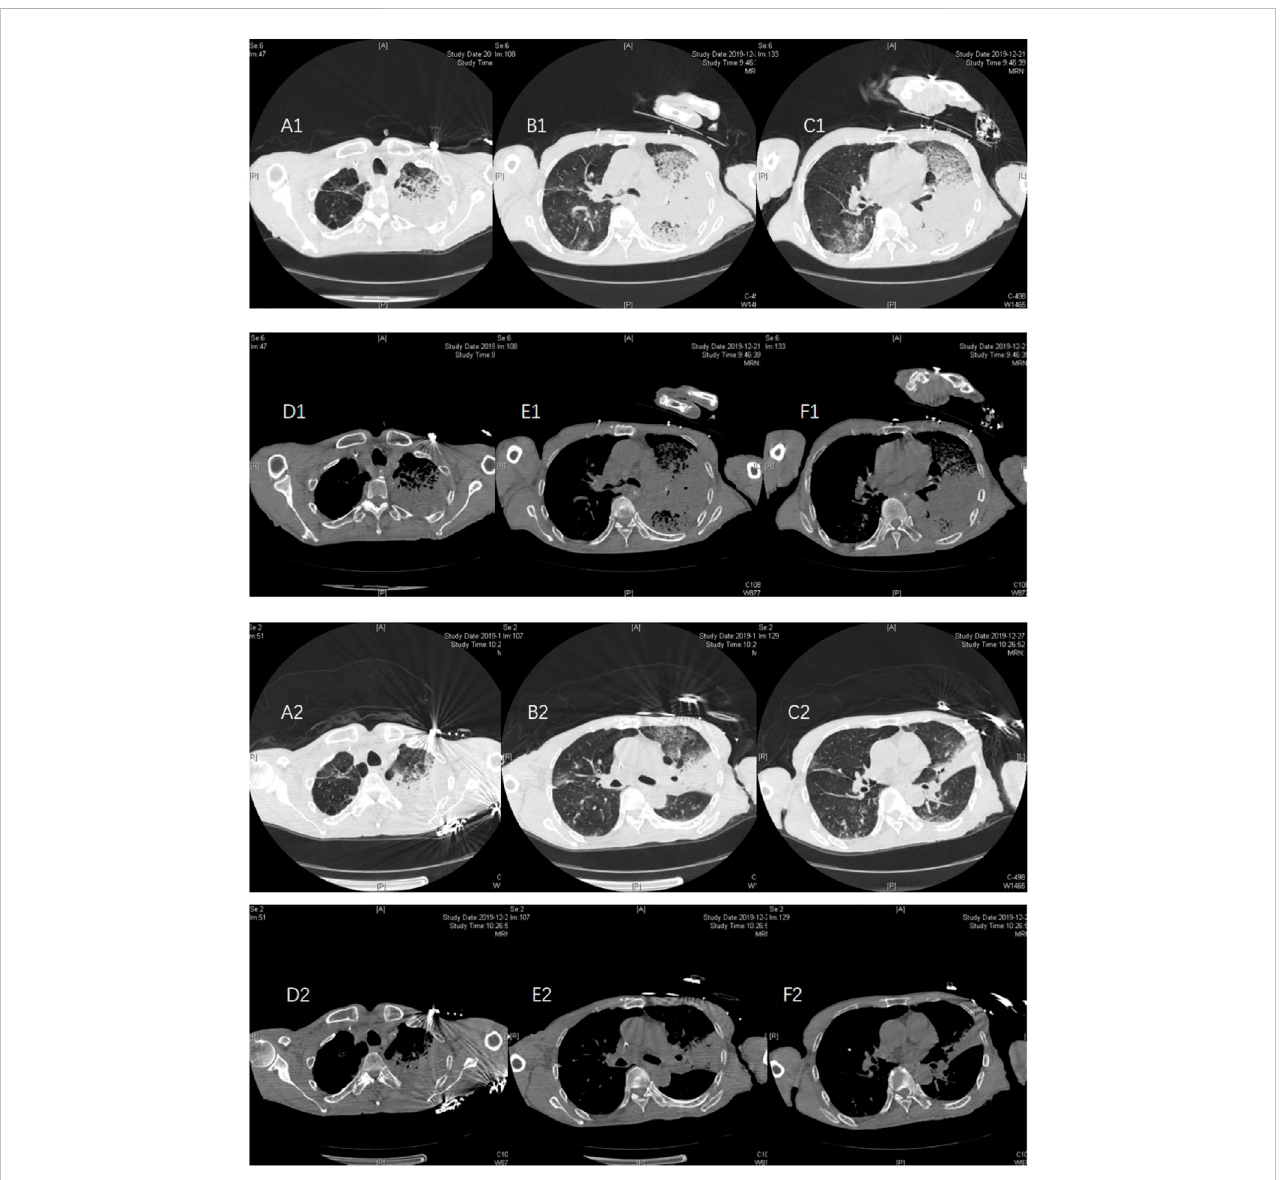
FIGURE 2 Case2,a72-year-oldmale,wasadmittedtothehospitalon21December,2019,dueto “ intermittentcoughandexpectorationfor8 months,aggravation with fever for 1 week, aggravation with disturbance of consciousness for 2 days. ” At the time of admission, pulmonary CT showed multiple patchy consolidations in both lungs, mainly in the left lung, and a small amount of pleural effusion (A1 – F1) on both sides. The patient had a fever during the previous antituberculosis treatment 8 months, and the relevant examinations for improved tuberculosis were negative. Considering that tuberculosis was stable, the patients were treated with doxycycline + meropenem after the diagnosis of NGS. On 27 December, 2019, pulmonary CT reexamination showed that multiple lung lesions were improved compared with the previous absorption, and bilateral pleural effusion was reduced compared with the previous absorption (A2 – F2)